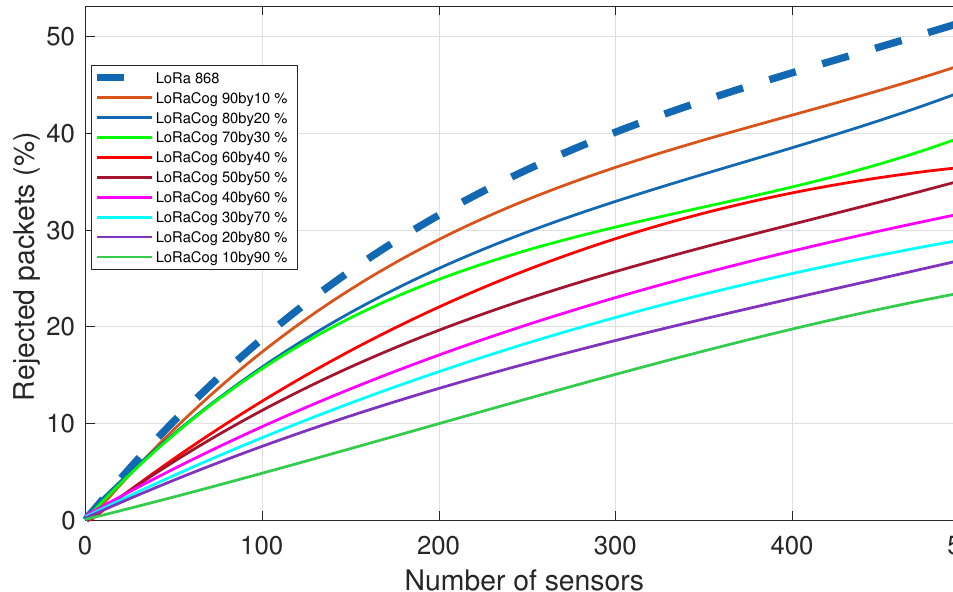
Figure 9. The evolution of the rejected packets for both LoRaWAN 868 MHz and LoRaCog 868/438 MHz for different percentage splits.